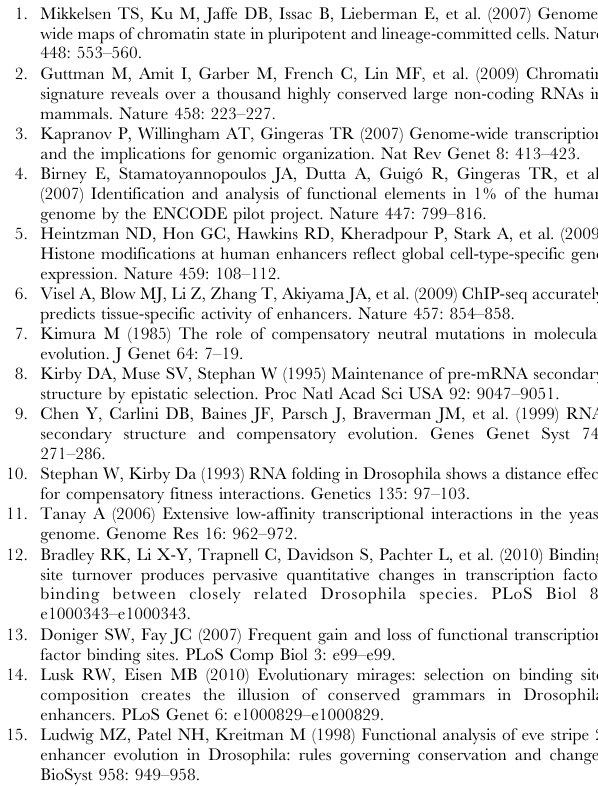
loss substitution rates around inferred A/T gain and A/T loss events across TSS-distal (E) and TSS-proximal (F) loci. Found at: doi:10.1371/journal.pcbi.1001039.s010 (0.39 MB EPS) Figure S11 Spatial coupling between A/T gain and A/T loss (horizon of 1 bp). Shown are the results of an analysis similar to the one shown in Figure 3, but with the horizon used for determining gain/loss context set to only one nucleotide (instead of 5 nucleotides). Found at: doi:10.1371/journal.pcbi.1001039.s011 (0.42 MB EPS) Figure S12 Spatial coupling between A/T gain and A/T loss (horizon of 3 bp. Shown are the results of an analysis similar to the one shown in Figure 3, but with the horizon used for determining gain/loss context set to only three nucleotide (instead of 5 nucleotides). Found at: doi:10.1371/journal.pcbi.1001039.s012 (0.39 MB EPS) Figure S13 Spatial coupling between A/T gain and A/T loss (horizon of 10 bp). Shown are the results of an analysis similar to the one shown in Figure 3, but with the horizon used for determining gain/loss context set to ten nucleotide (instead of 5 nucleotides). Found at: doi:10.1371/journal.pcbi.1001039.s013 (0.46 MB